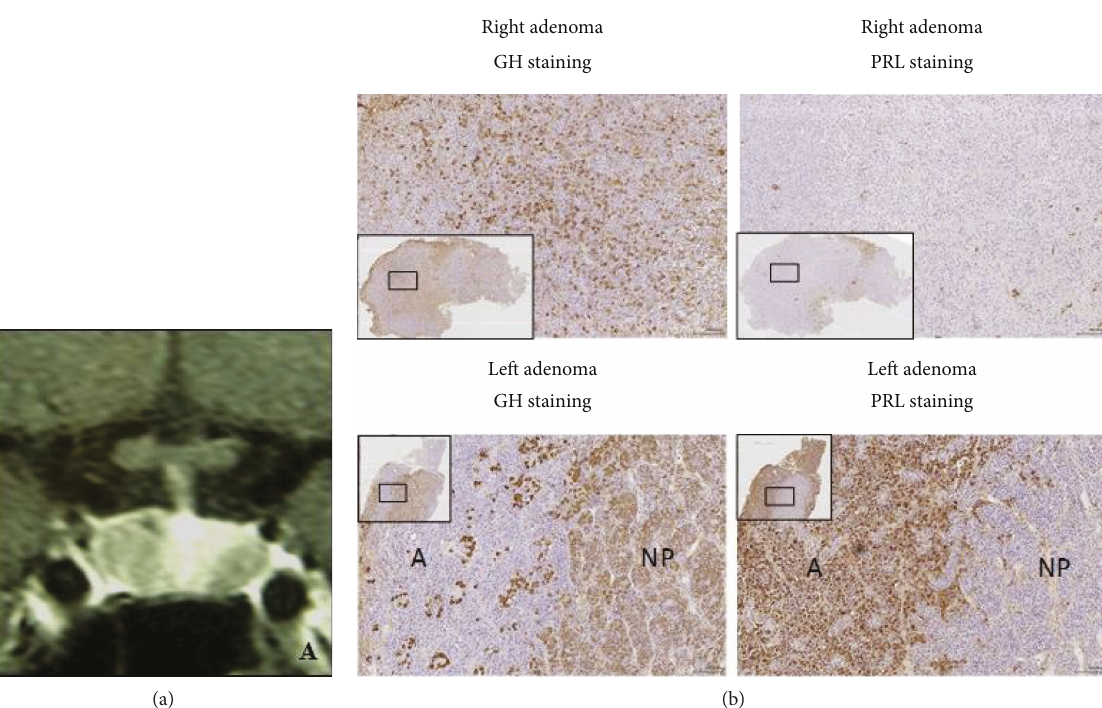
Figure 3: (a) Pituitary MRI of the proband ’ s second cousin (case 4) showing right 6mm and left 4mm PAs. (b) Immunostaining of the right (upper 2 panels) and left (lower 2 panels) PAs. The right adenoma shows strong GH and scattered prolactin staining. The lower panels show the left adenoma containing adenoma tissue (A), which stains strongly for prolactin and shows only scattered GH staining, and normal pituitary tissue (NP) which is visible in many GH-stained cells.